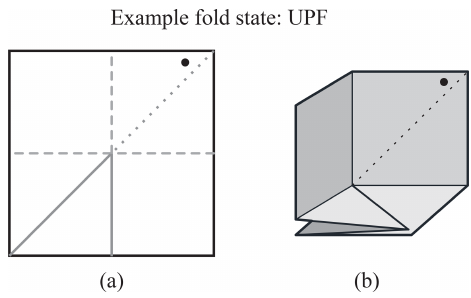
Figure 19. A crease pattern (a) with fold-angle assignment that will result in a PF fold state (b) . The legend for fold-angle assignment is given in Fig. 8. The PF fold state is useful for creating 3-D structures with reduced degrees of